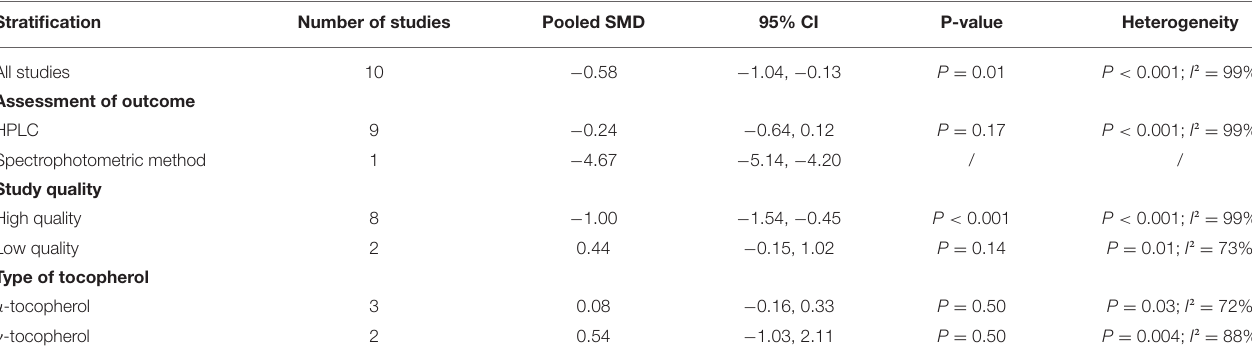
TABLE 5 | Subgroup analysis for SMD of circulating vitamin E level in MetS vs. control